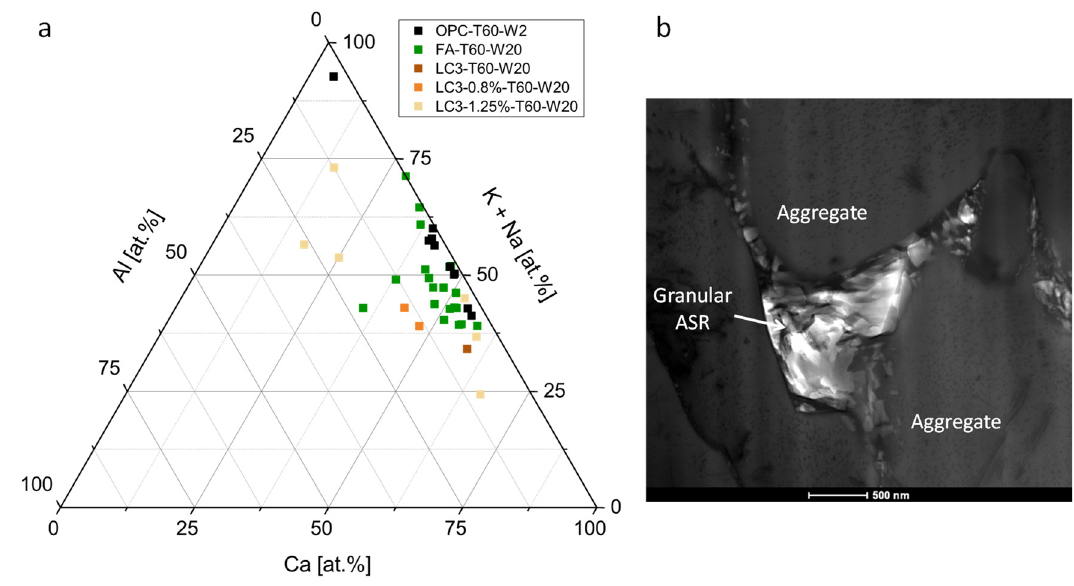
Figure 6. (a) Ternary diagram presenting the ASR products composition present in different concrete mixtures in atomic ‐ %, normalized among Ca, Al, K and Na. (b) Morphology of ASR product in FA containing sample, appearing at grain